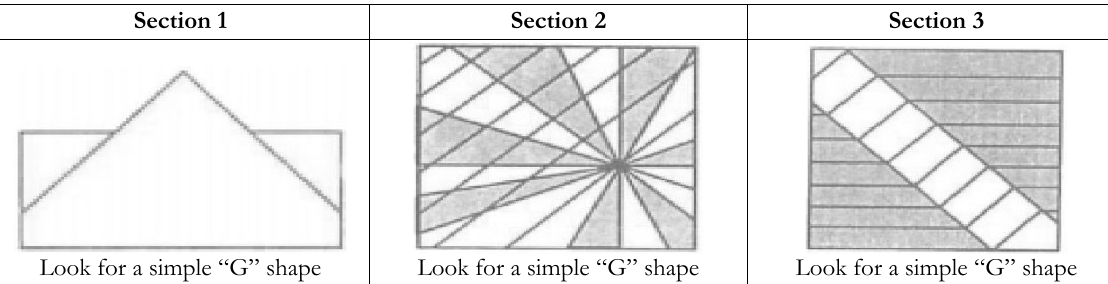
Table 2. Group Embedded Figure Test (GEFT) in Each Section